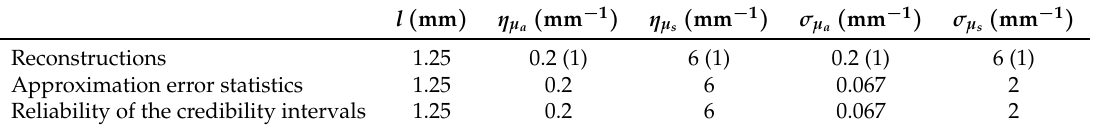
Table 2. Prior parameters used in the simulations. l is the length scale parameter, η µ is the mean of the a absorption, η µ is the mean of the scattering, σ µ is the standard deviation of the absorption and σ µ s a s is the standard deviation of the scattering. Values given are for the non-scaled parameters, and the corresponding values for the (unitless) scaled parameters (utilized in reconstruction procedure) are given in parentheses. ( mm − 1 ) η µ ( mm − 1 l ( mm ) η µ a s